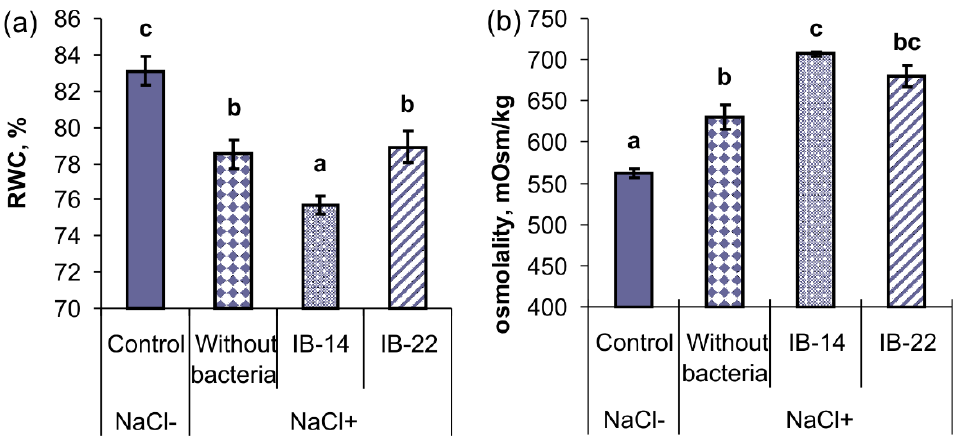
Figure 2. Effect of salt-stress and seed bacterial inoculation on leaf relative water content ( a ) and osmolality ( b ) of wheat plants at the stage of tillering in the field experiments: IB-14 —P. mandelii IB–Ki14; IB-22— B. subtilis IB–22; control—option without bacterization and salinity. Significantly different means for each variable are labeled with different letters ( n = 5, p ≤ 0.05; LSD test).